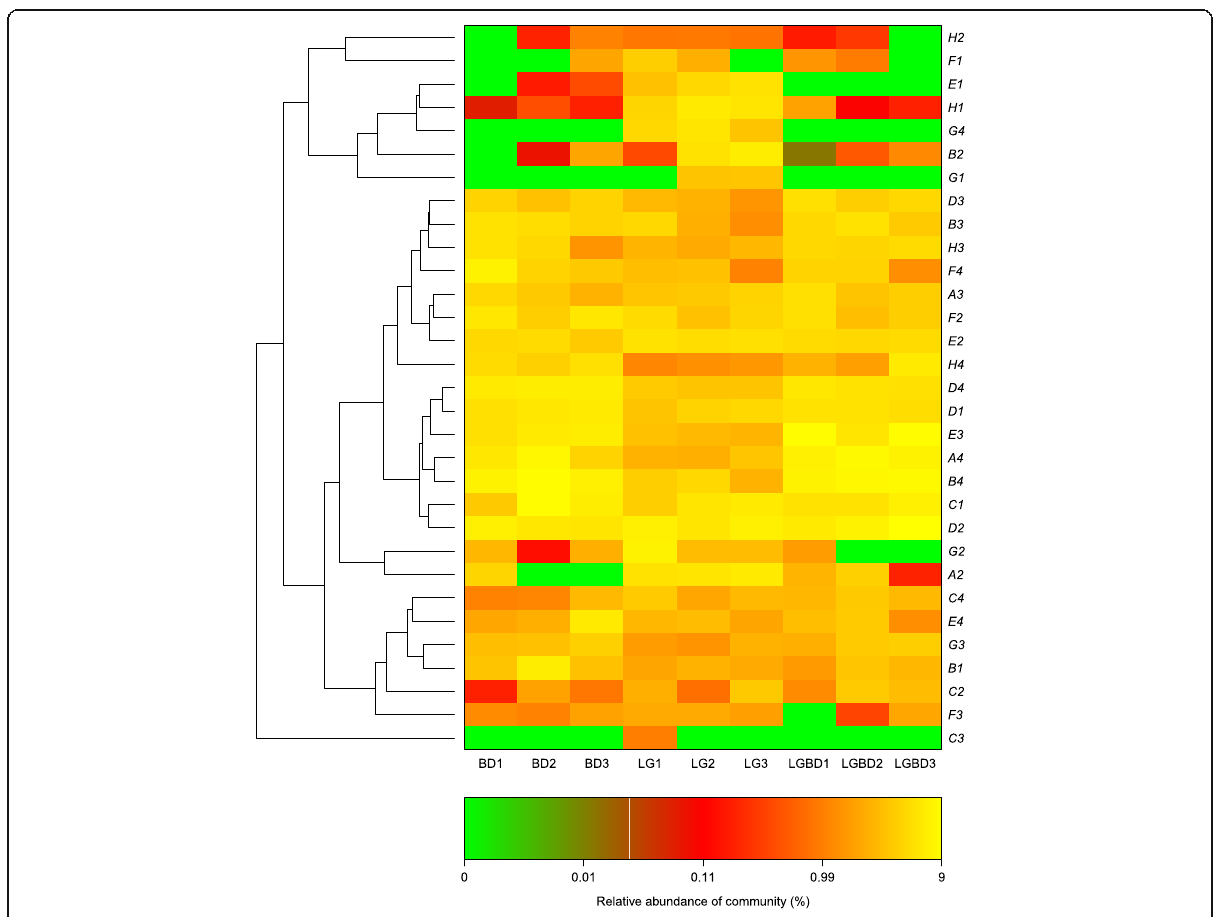
Fig. 3 Heatmap and hierarchical cluster analysis based on the AWCD of 72 h for the soil microbial communities with different revegetation types. Note: The samples are grouped based on the similarity to each other, and the clustering results are arranged horizontally according to the clustering results. In the figure, red represents the higher AWCD in the corresponding sample, and green represents the lower AWCD. LG, Larix gmelinii ; BD, Betula dahurica ; LGBD, mixed Larix gmelinii and Betula